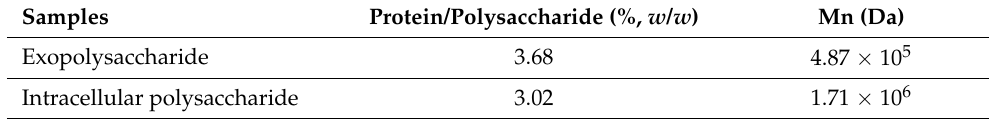
Table 2. Number-average molecular weights and protein contents of polysaccharides.